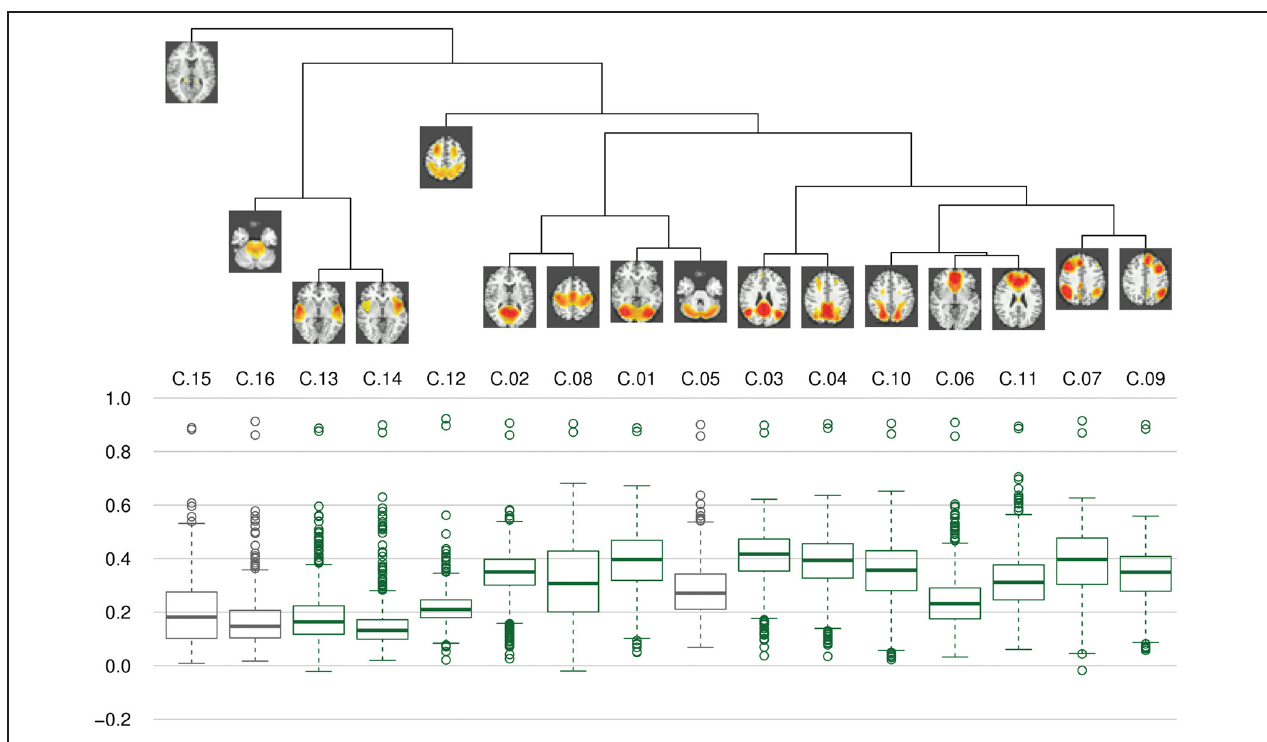
FIGURE 4 | Clustering and consistency of results. On top, a dendrogram represents results of hierarchical clustering using complete linkage distance between clusters. Below, boxplots of correlation coefficients illustrate the consistency of components between subjects. Boxes for gray matter